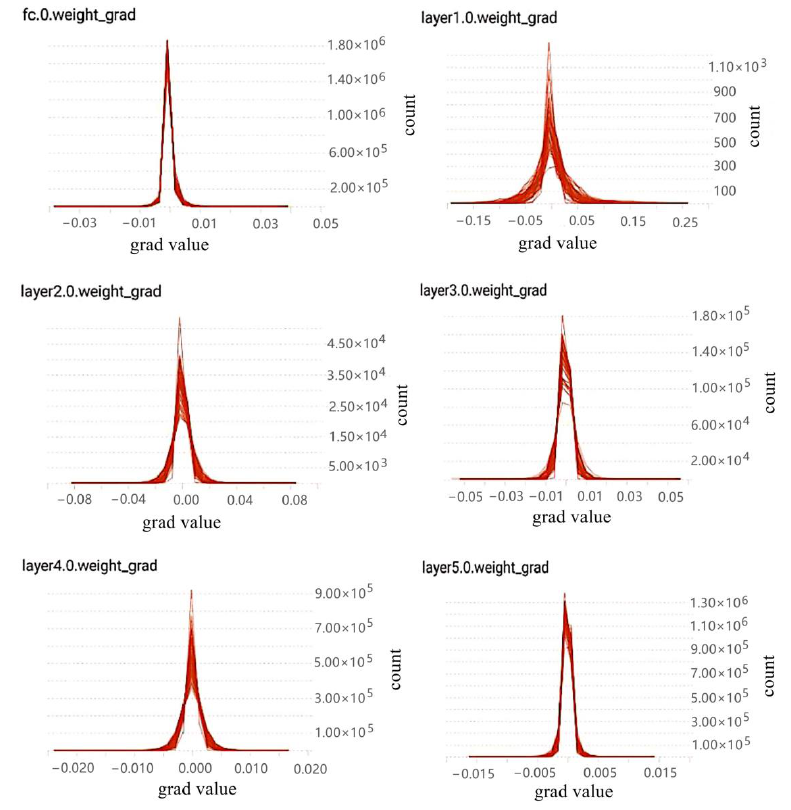
Figure 2. Gradient distribution histogram of some layers sampled in